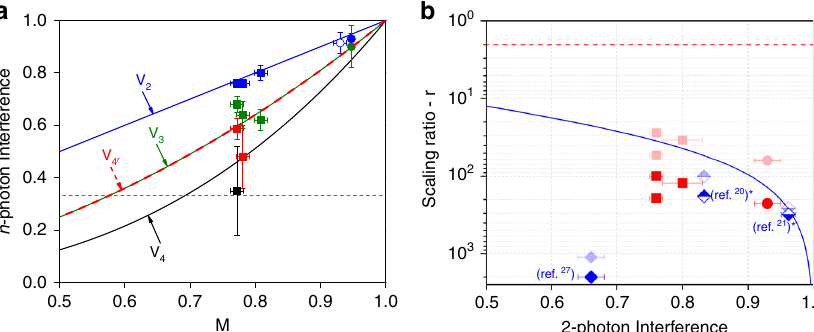
Fig. 4 Entanglement criteria. In both panels, solid squares and solid circles represent results using a charged excitation, with and without spectral fi ltering, respectively, while the empty circle represents results for neutral excitation without spectral fi ltering. a n -photon interference vs. indistinguishability values M of various experiments. Blue, green, red, and black represent V V V V 2 , 3 , 4 results, respectively. The curves represent calculated theoretical values 4 0 , and for noise-induced distinguishability. Results for V 4 are normalized to one. Horizontal dashed magenta line is the entanglement length interference threshold. b A comparison between scaling ratios as a function of the two-photon interference for various single-photon source implementations. Solid blue diamond correspond to an experiment implemented with a PDC source and a free space setup 27 . Half- fi lled blue diamonds correspond to the calculated value, where the best PDC source currently available 20,21 would have been used in our setup. Red symbols correspond to the results of the present work. Light-color symbols represent calculated values for η d = 0.9. (*) The scaling ratios for the refs. 20,21 were calculated based on published photon rates, interpreted as an heralding single-photon source. Dashed red (solid blue) line represents the theoretical probabilistic gate (heralded PDC sources) limit. See text for further